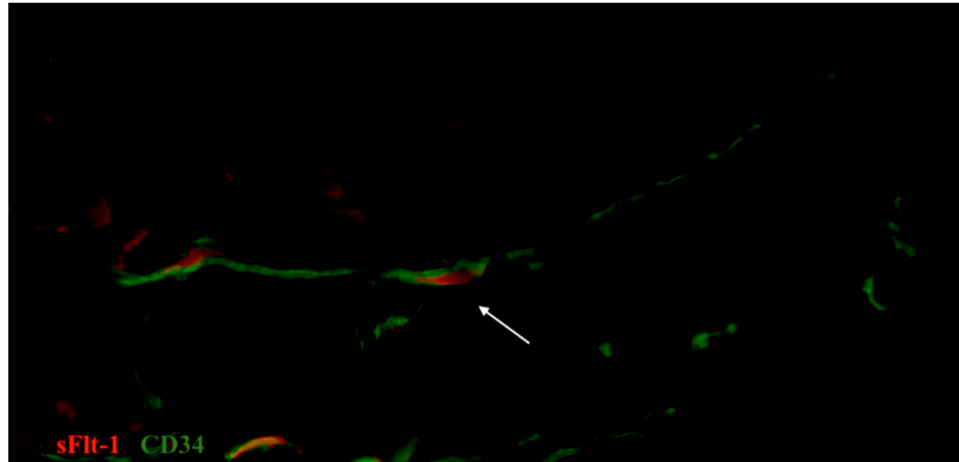
Figure 11. Sample of oviduct stained for sFlt-1 (VEGFR-1) (red, Alexa Fluor 594) and CD34 (green, Alexa Fluor 488). The interaction between telocytes and the expression of the hypoxia marker is shown by the arrow. The high sensitivity of telocytes to hypoxia and their distribution in close vicinity to blood vessels is proved by their co-expression with markers of hypoxia in tissue sample. Total magnification: × 600.